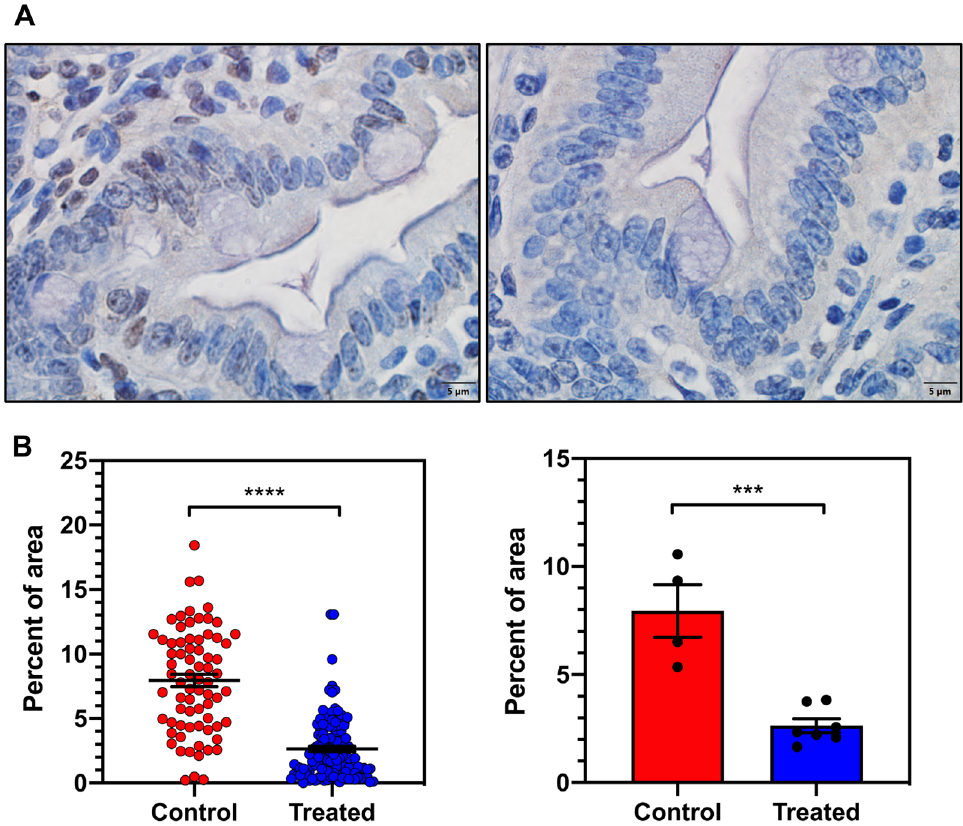
Figure 4. ( A ) Microscopy images (100 x) with IHC staining for symmetric dimethylarginine (SDMA) in intestinal tissue from untreated APC Min/+ mice (left) and those treated with 20 mg/kg/day MTDIA (right) euthanized at 150 days. SDMA signal (brown) was reduced in MTDIA-treated mice. ( B ) Quantitative data from four control and seven MTDIA-treated mice from IHC staining experiments. The left panel shows quantitative signal intensity from all ROIs among all control and treated mice with an observed statistically significant decrease in SDMA signal among MTDIA treated mice ( p < 0.0001). The right panel shows mean ROI signal intensity for each individual mouse, with mean signal intensity three-fold less in MTDIA treated mice compared to controls ( p <